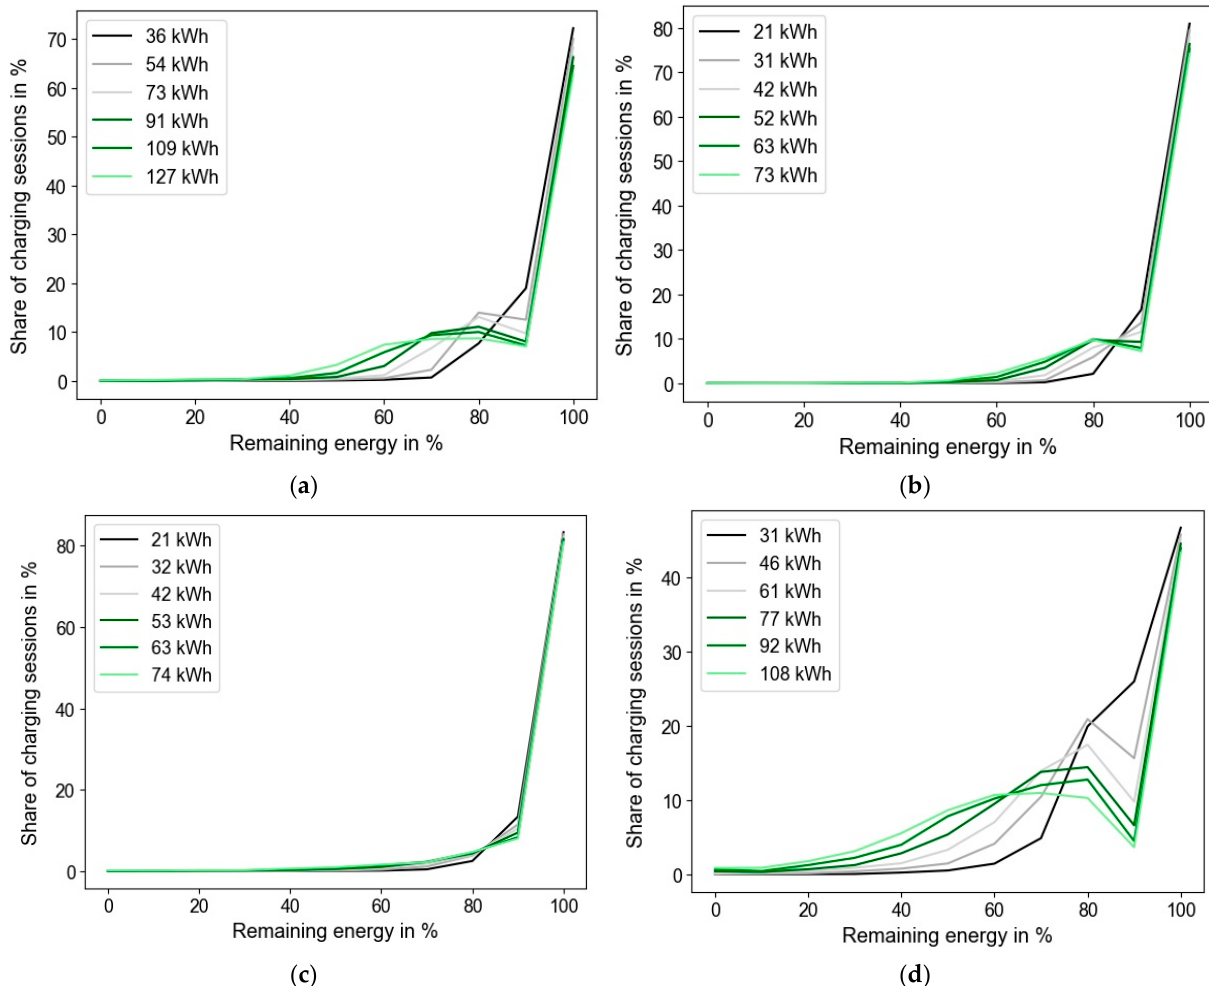
Figure 6. The impact of the optimal load reduction schedule on customers with different amounts of reduced energy during business days. Remaining energy refers to the energy in the battery of the EV after the load reduction. The non-affected cases are marked in purple: ( a ) Car park; ( b ) Office; ( c ) Residential; ( d ) Shopping center.